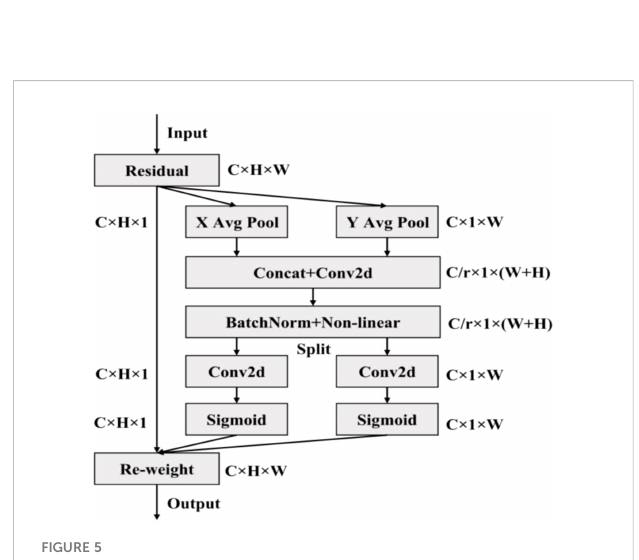
FIGURE 5 Structure of the CA